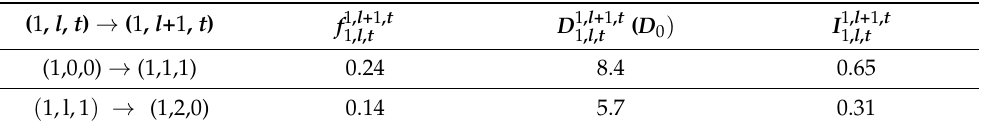
(4) (where D 0 = e ˚A in Debye units), and radiation intensity I 1, l + 1, t electron transitions between the quantum-confined states ( n = 1, l , t ) → ( n = 1, l + 1, t ) (where l = 0, 1 and t = 0, 1) in the QD perovskites FAPbBr 3 with radius a = 5.5 nm.